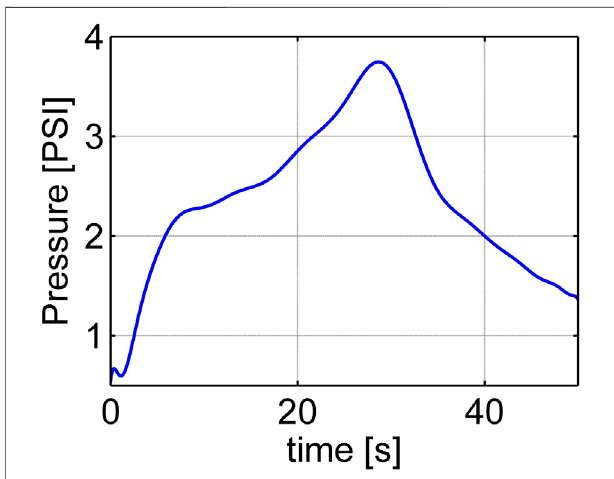
FIGURE9| Inputpressurefortheexperiment toestimatecontactforces and the robot